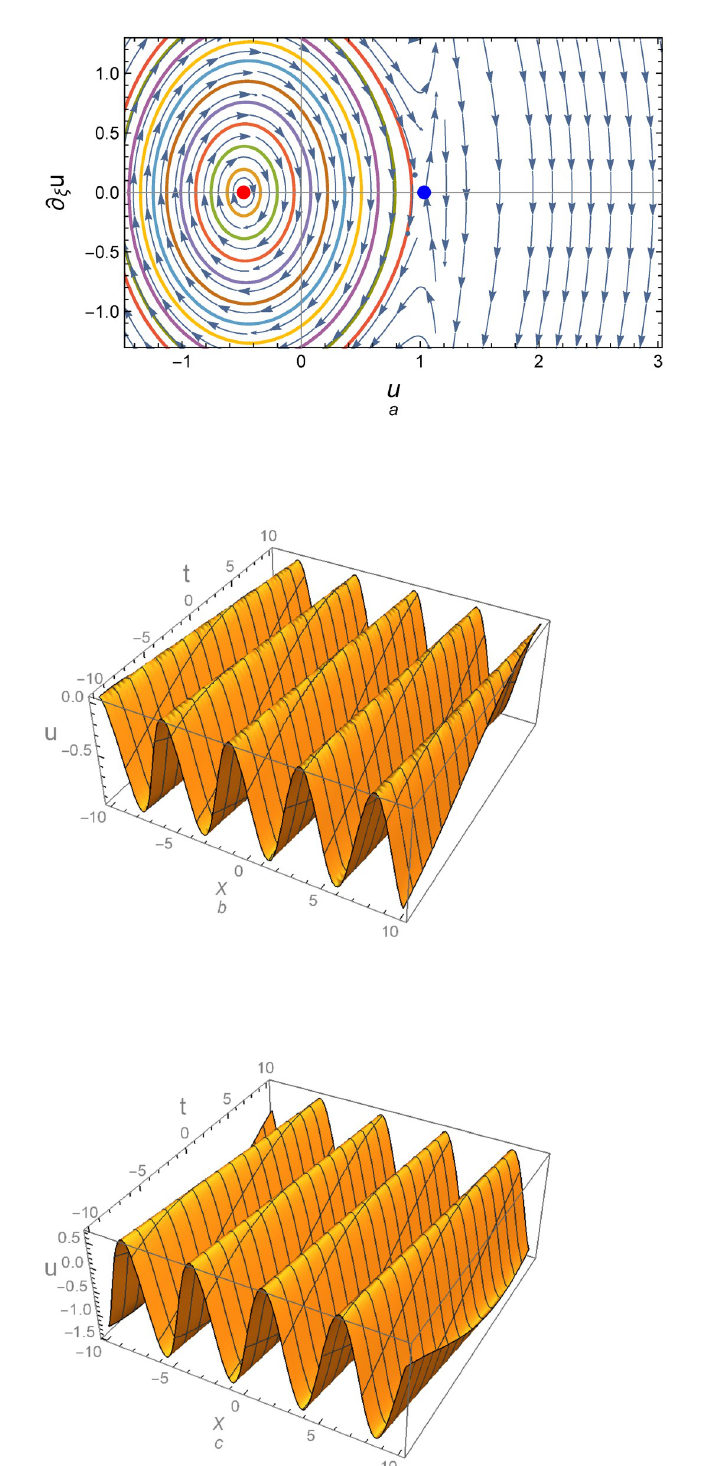
Fig 3. (a) Phase portrait for system (5) for c 0 = 1.2, c 1 = − 2, c 2 = 0.1, c 3 = 0.941527, D = 1, k = 1, α = 1, γ = 1, λ = − 0.1, � = 1, A = 0, and B = − 1, (b) Profile of the solution according to the saddle point (Right-Blue point), and (c) Profile of the solution according to the central point (Left-Red